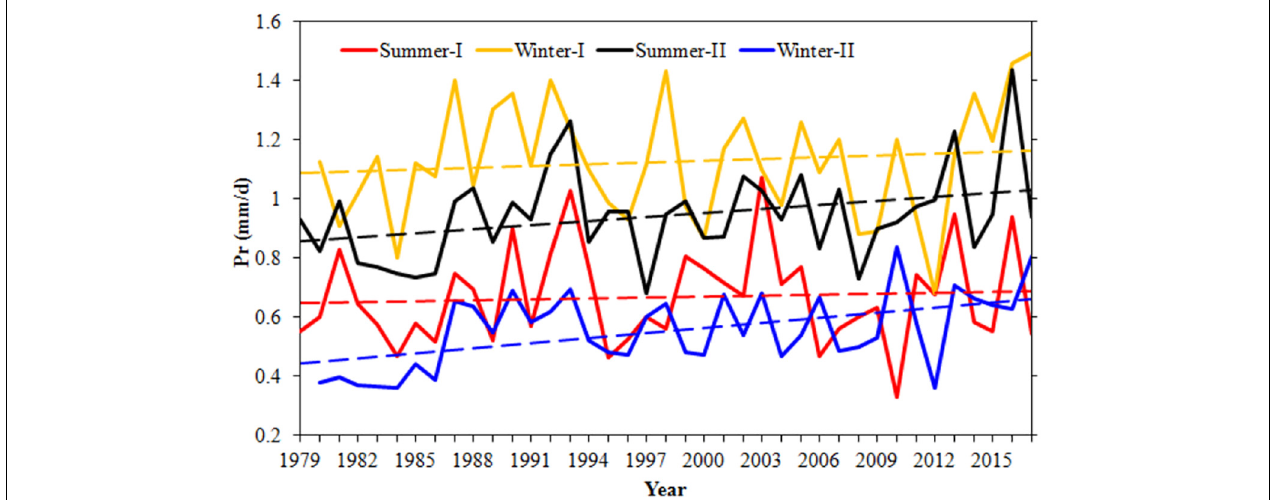
FIGURE 3 | Variation and linear trends of winter and summer precipitation in regions I and II of Central Asia during the time period 1979–2017 (dotted lines are the linear fits).